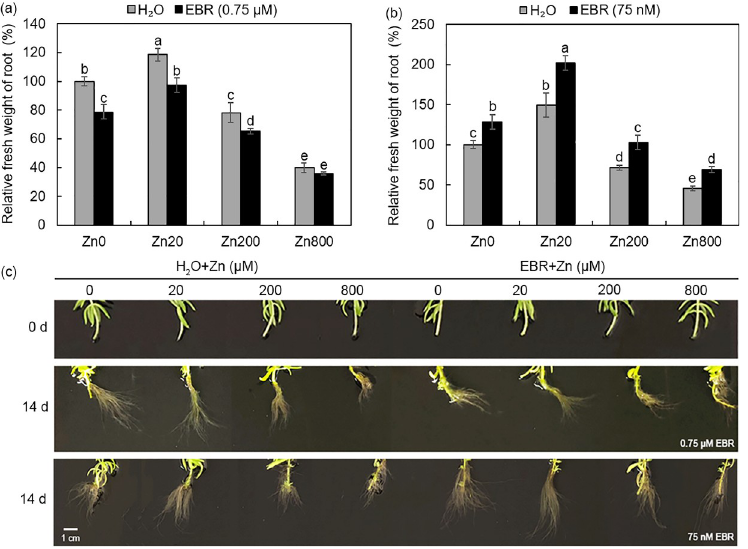
Fig 2. Effects of different concentrations of zinc and EBR on root growth of S . lineare . (a) Relative root fresh weight of S . lineare treated with 0, 20, 200 and 800 μ M ZnSO 4 and sprayed 0.75 μ M EBR for 14 d. (b) Relative root fresh weight of S . lineare treated with 0, 20, 200 and 800 μ M ZnSO 4 and added 75 nM EBR to culture medium for 14 d. (c) Photos of S . lineare root treated with Zn and EBR for 14 d.